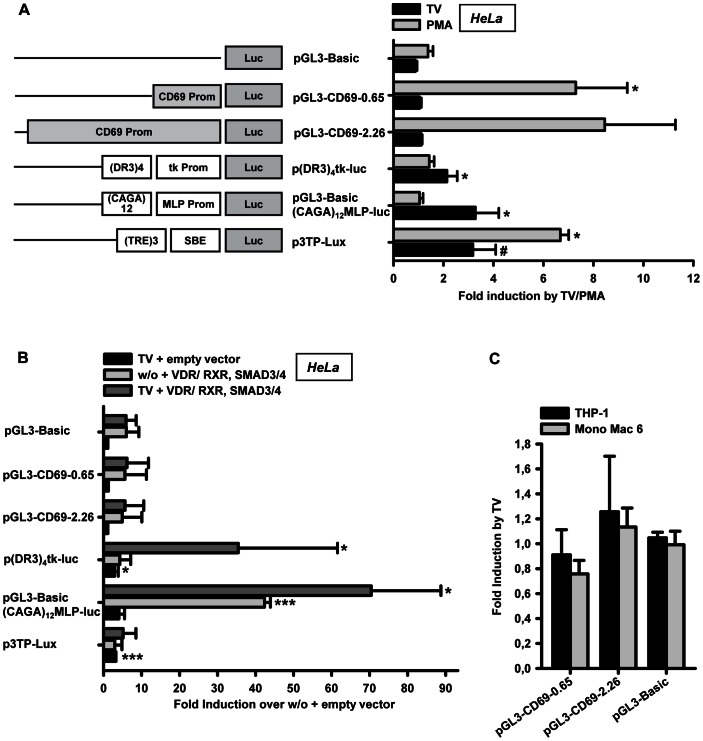
Reporter gene analysis of the proximal CD69 promoter.(A) HeLa cells were transfected with the indicated reporter plasmids and treated with or without 1 ng/ml TGF-β and 50 nM 1α,25(OH)2D3 (TV) or 15 ng/ml phorbol 12-myristate 13-acetate (PMA). Luciferase activity was measured 24 h after treatment as described under “Materials and Methods”. The values are expressed as fold induction over untreated cells. Statistical analysis was performed with one sample t-test (*P<0.05; # = 0.0538). (B) HeLa cells were transfected with the indicated reporter plasmids and expression vectors encoding human vitamin D receptor (VDR), retinoid X receptor (RXR), Smad3 and Smad4 or the corresponding empty vectors. Cells were either treated with 1 ng/ml TGF-β and 50 nM 1α,25(OH)2D3 (TV) or left untreated (w/o). Luciferase activity was measured 24 h after treatment. The values are expressed as fold inductions over untreated cells cotransfected with empty vectors. Statistical analysis was conducted with one sample t-test (*P<0.05; ***P<0.001). (C) THP-1 or Mono Mac 6 cells were transfected with the indicated reporter plasmids and were treated with or without 1 ng/ml TGF-β and 50 nM 1α,25(OH)2D3 (TV). After 12 h (THP-1) and 8 h (Mono Mac 6), luciferase assay was performed. The values are expressed as fold induction over untreated cells.